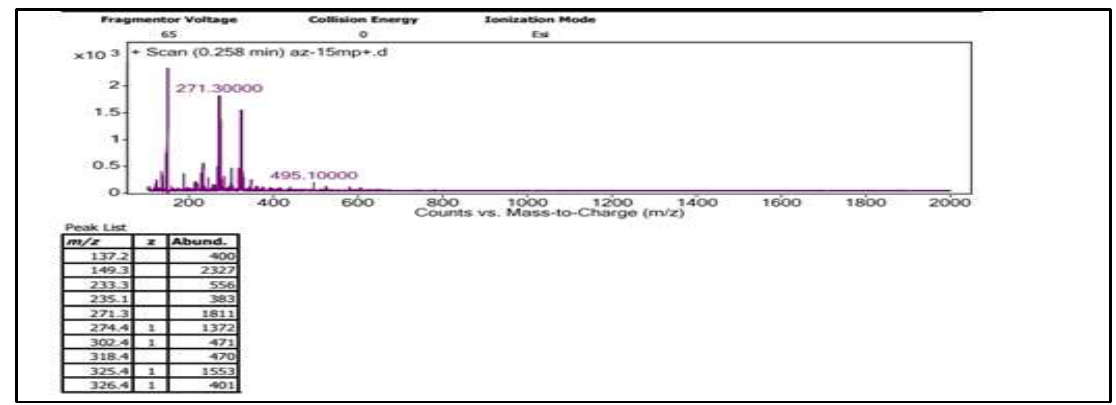
LC/MS of isolated compoundsA4(1): the result show in Figure11.